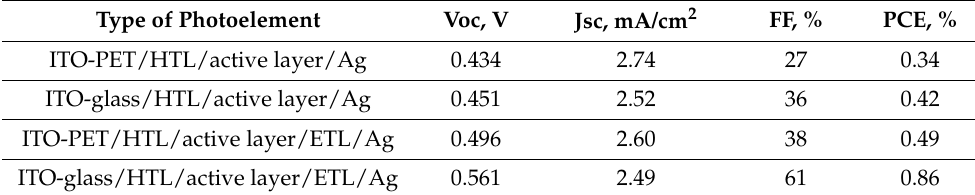
Figure 3. I–V characteristics of P3HT:PCBM-based solar cells without ETL constructed under environmental conditions on: ( a ) flexible PET substrates and ( b ) glass substrates. Table 1. Photovoltaic parameters of solar